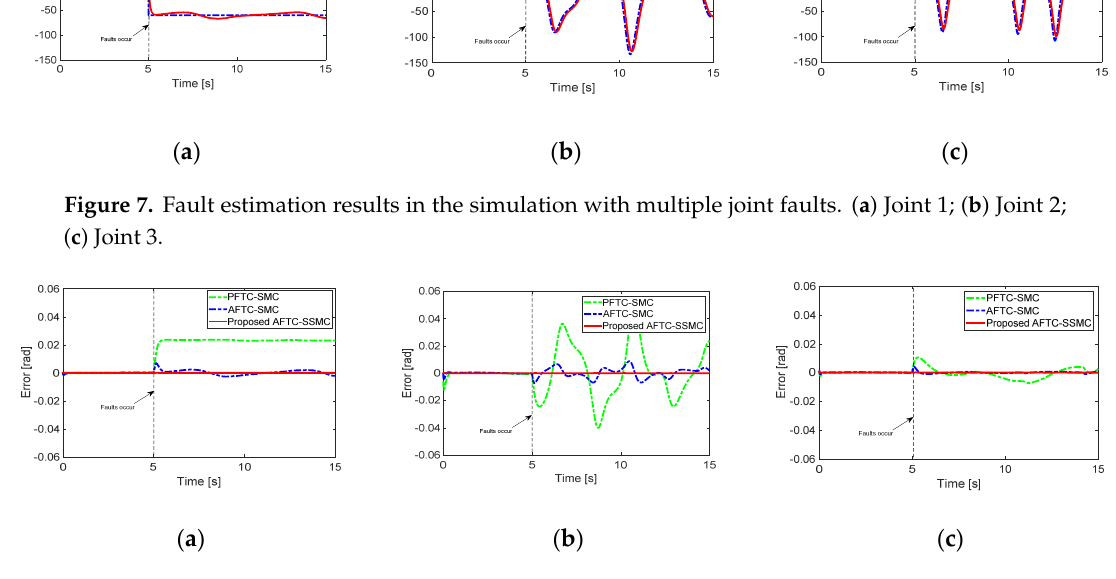
Figure 8. Tracking error at each joint in the simulation with multiple joint faults. ( a ) Joint 1; ( b ) Joint 2; ( c ) Joint 3.